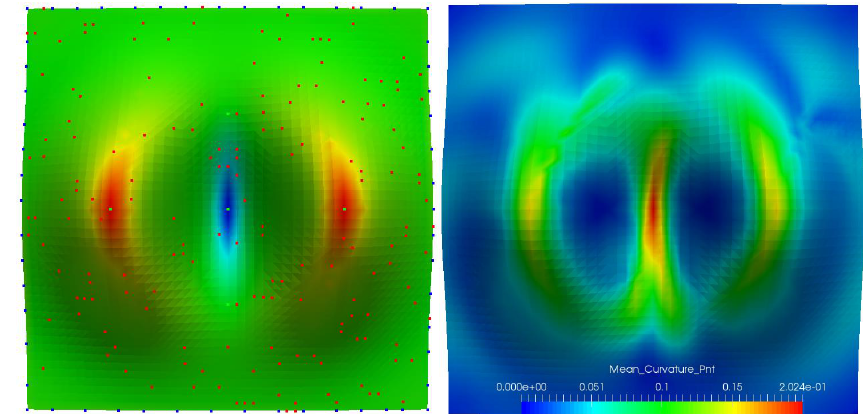
Figure 1. High-resolution grid of a mountain (Eq. 5). Left: original grid oriPd in 49 × 49 resolution, rendered in mean curvature. The sample points were also rendered on oirPd; the blue points are boundary points, the green points are critical points, and the red points are random points. Right: robust mean-curvature estimation. The saddle terrain features, peaks, and pits can be distinguished, compared to the depiction on the left.